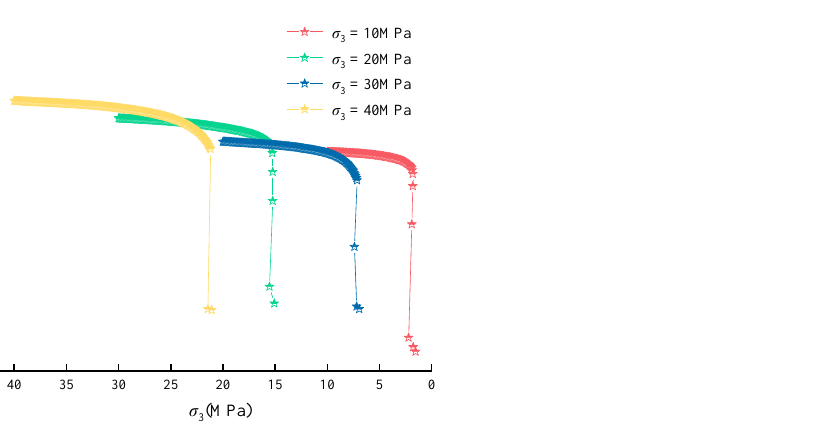
Figure 6. Relationship between elastic modulus and confining stress during unloading.